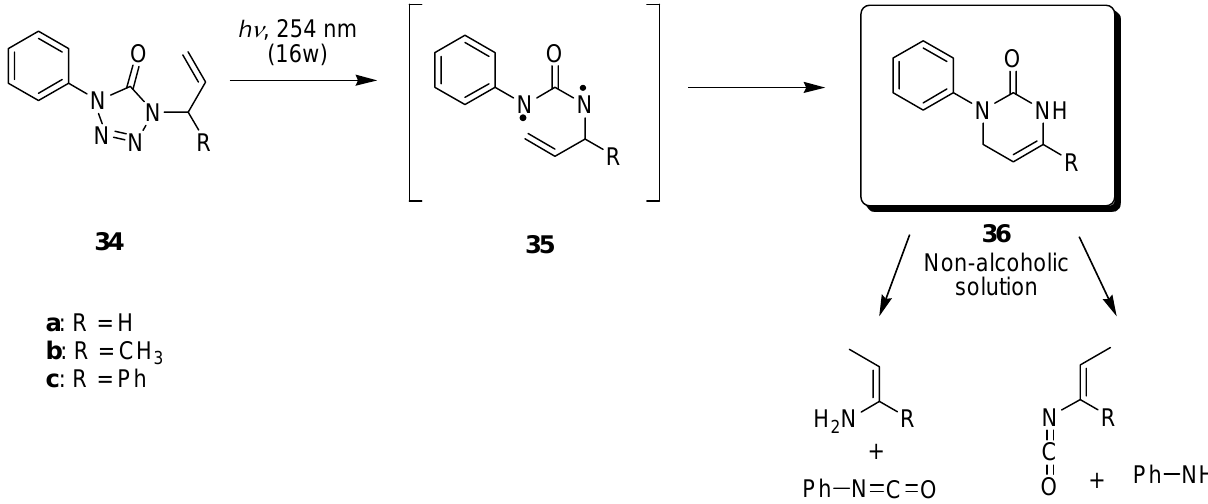
Scheme 11. Synthesis of 3,4-dihydro-6-substituted-3-phenylpyrimidin-2(1 H )-ones